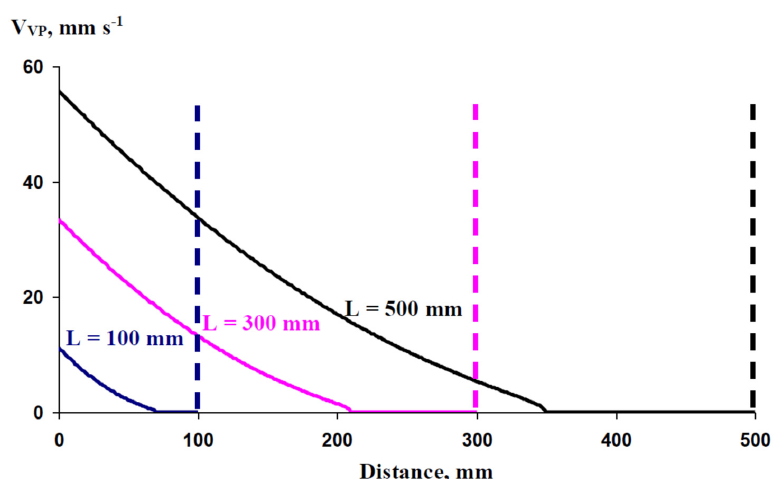
Figure 5. Simulated dependence of the propagation rates of variation potential (V VP ) on the distance from the damaged zone at different lengths of the xylem vessel (L). L is 100, 300, and 500 mm. The duration of hydraulic changes in the damaged zone (t R ) is assumed as 50 s. The ratio of the P’ integral, which is necessary for variation potential induction, to the total P 0 ’ integral in the zone of damage (N) is assumed as 0.3. Variant 1 (V1) of the model was used in this analysis (see Figure 1b). Dotted lines show the lengths of the vessels (L) that were used for analysis.